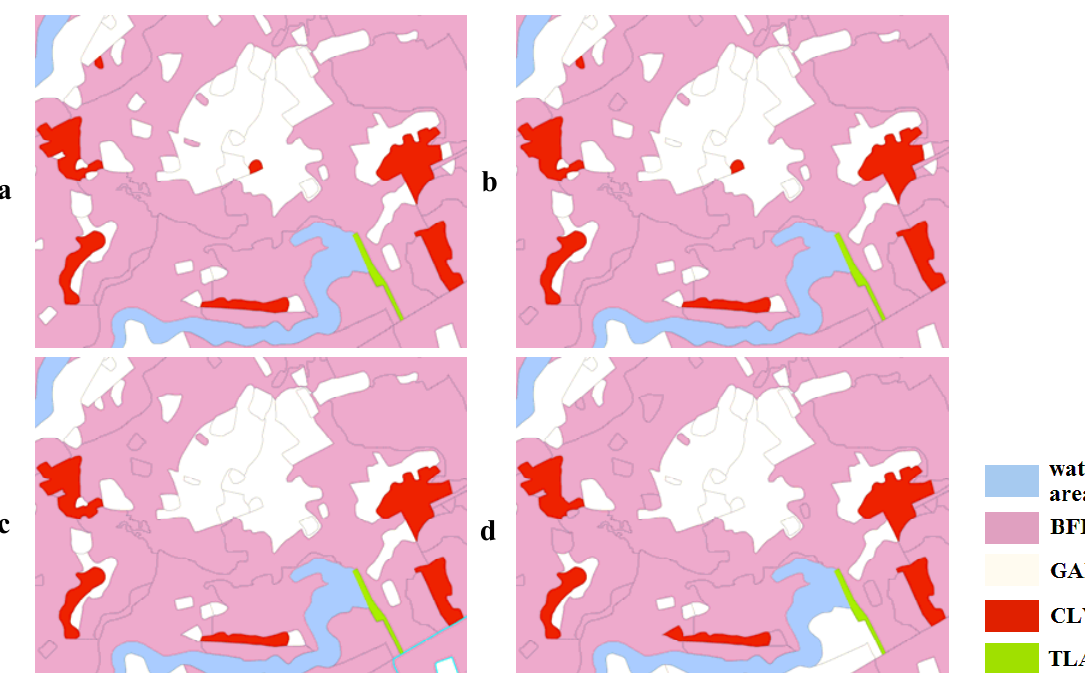
on optimizing the spatial pattern in different weighted Figure 8. The effects of w 2